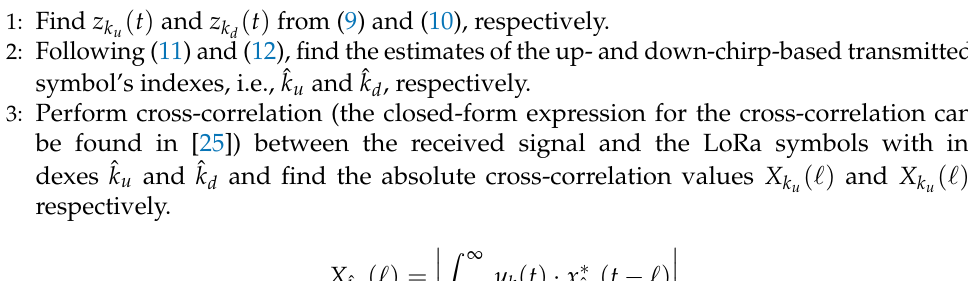
Algorithm 1 Hybrid Demodulation